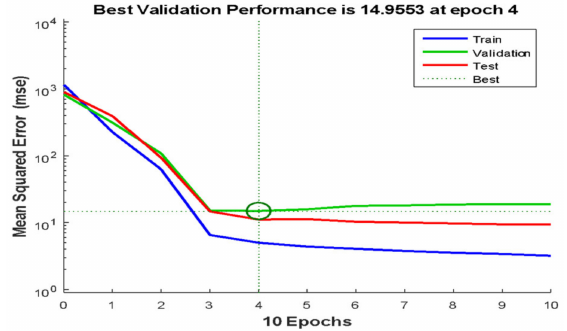
Figure 15. Network training cycles in site 1.